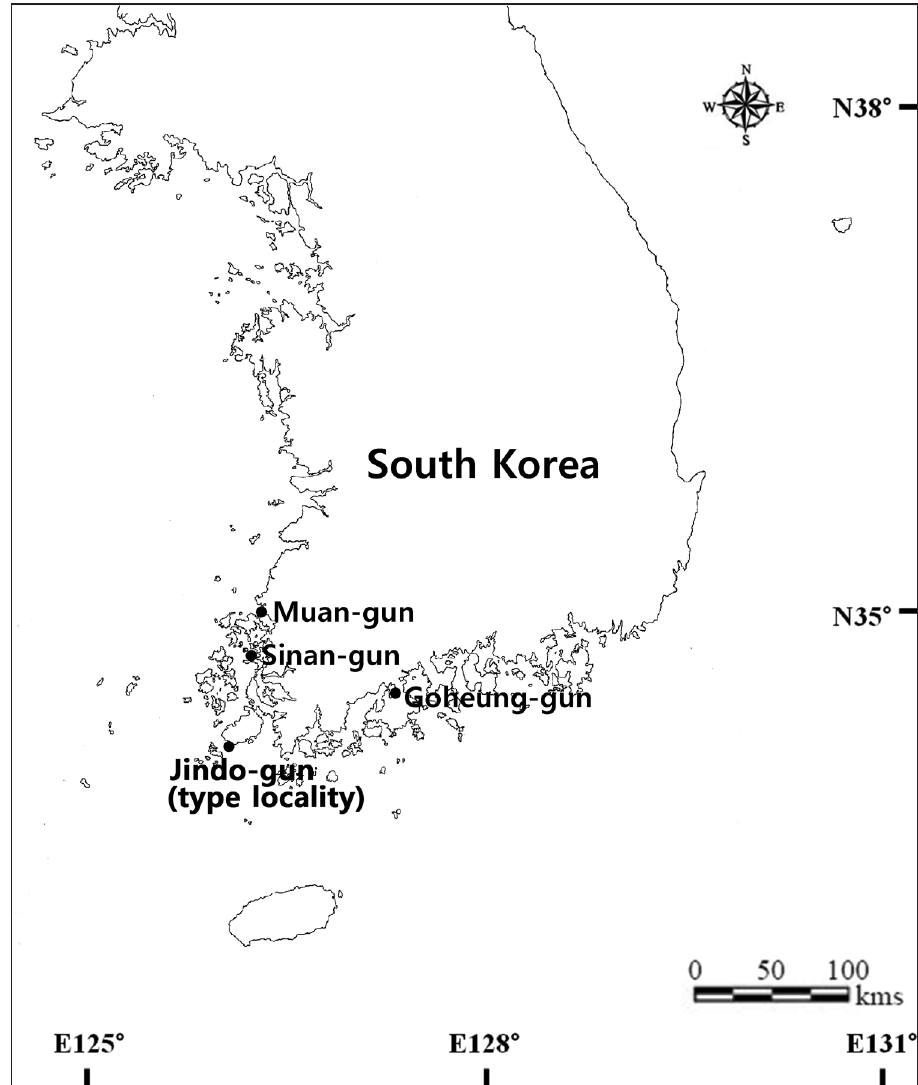
Figure 1. Localities of the sampling stations of the present study in South Korea. by seta. Caudal rami approximately 2.5 times (female) and 3.6 times (male) as long as width; tube pore on outer margin inserted proximally; caudal seta VI shorter than seta IV. Antennary endopod with stout spine-like seta at distal corner. Mandibular gnatho- base with 3 bicuspid teeth, without seta; basis with 2 short and 1 long setae. Female P5 exopod 3.5 times as long as width; innermost seta on exopod shorter than exopod in length; endopodal lobe approximately 2.7 times as long as width. Male P5 endopodal lobe, outer most seta on endopodal lobe reaching half of middle seta on